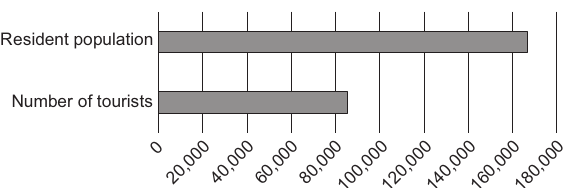
Fig. 6. The structure of total accommodation capacity in the Danube Gorge